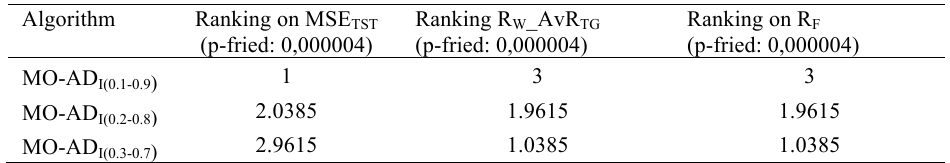
Table A.3 Rankings obtained through Friedman’s test for different values of thresholds on MSE TST , R W _AvR TG and #R F measures using WM rule bases for MAX INT